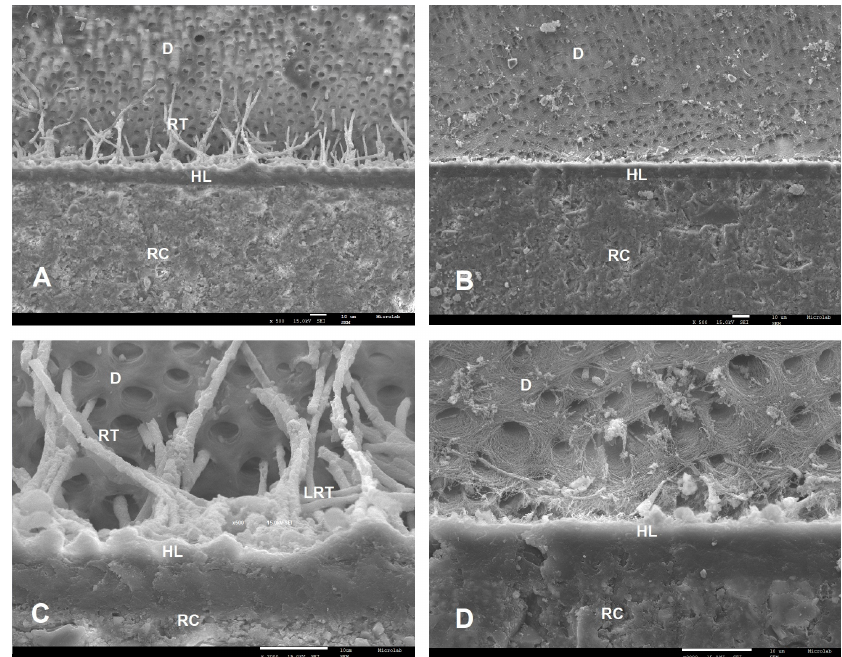
Figure 1. SEM micrographs of bonding interface of the commercial adhesives when ER was applied. Magnifications of 500 × ( A , B ) and 2000 × ( C , D ) were used. A and C —SBU with 11.3 µ m of hybrid layer (HL) thickness; B and C —FUT with 7.6 µ m of hybrid layer (HL) thickness. Any resin tags (RT) and lateral resin tags (LRT) were identified. RC—resin composite; D—dentin; HL—hybrid layer; RT—resin tags; LRT—lateral resin tags.